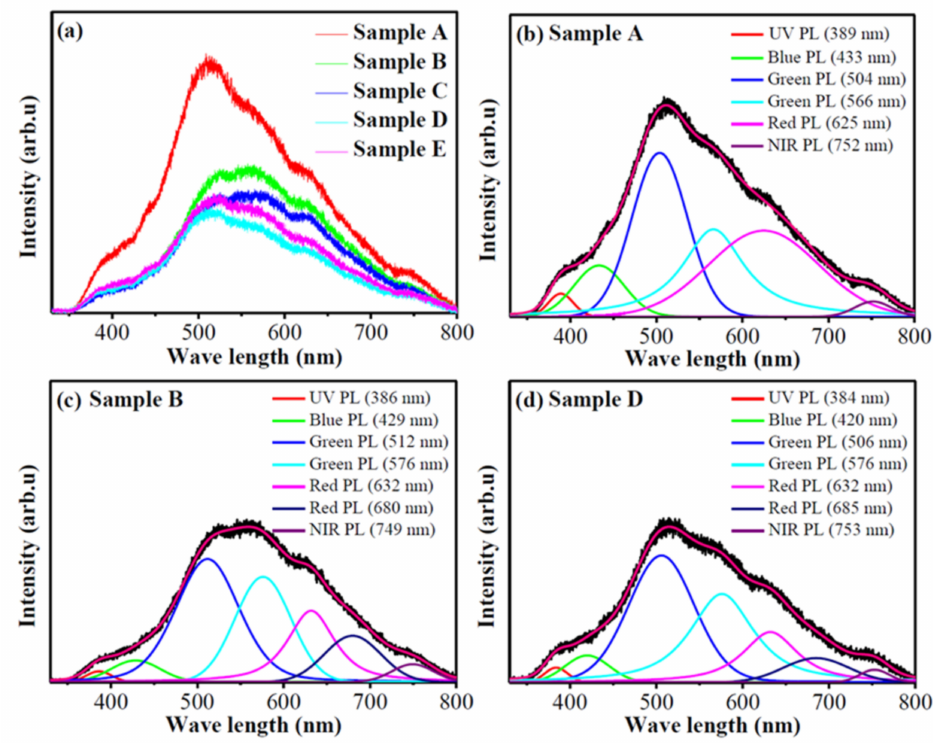
Figure 11. ( a ) PL spectra of samples A–E and ( b – d ) deconvoluted PL peaks for the PL spectra of samples A, B and D. The data in the images ( b – d ) correspond to the wave lengths of PL